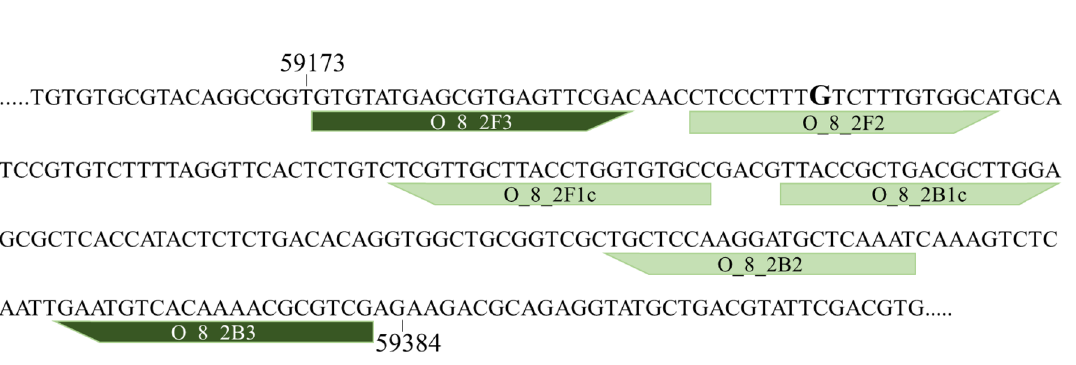
Figure 2. Position and orientation of the primer sequences in the scaffold (accession number CAJHJB010000001) that was used for the development of T. controversa LAMP assay. Binding sites for outer primers are shown in dark green, for inner primers in light green. Separation of the binding part is shown with the (_) in the primer sequences. The numbers show the position of nucleotides in the DNA segment. The nucleotide (G) shown in bold is changed to wobble position (K) in the primer sequence, after resequencing of the target T. laevis (shown in dark red) shared > 99% sequence identity with an average of 91% alignment coverage of the total genome length. In this group, two clades corresponding to common bunt ( T. caries and T. laevis ) and dwarf bunt ( T. controversa ) were discriminated using single linkage cluster analysis. Tilletia caries and T. laevis clustered together in a common clade, with little genetic distance from its neighboring clade comprising the genomes of T. controversa . In comparison, the identity within T. indica genomes was > 97% with an average of 79% alignment coverage. The genomes of T. indica shared on average 94% sequence identity to the single T. walkeri genome. In the second group, T. indica samples were separated from the single representative of T. walkeri. The program rapid identification of PCR primers for unique core sequences (RUCS) 36 was used to identify species-specific sequences in the genome of T. controversa . A total of 11,136 unique DNA segments (N50 = 61 bp) were obtained, of which 22 were longer than 1500 bp. These sequences were used for the design of LAMP primers. A total of 78 primer sets were designed and initially tested for their specificity against a preset comprising eight (three T. caries , three T. controversa , and two T. laevis isolates) selected cultured samples (Supplementary Table S3 shows the list of cultured samples). The primer sets with no false detection and strong amplification as visualized on agarose gels were selected. The second round of testing was performed against the samples of com- mon and dwarf bunt only. The primer sets were excluded when a false positive or false negative reaction occurred. The remaining primer sets were then tested against other Tilletia species and fungal pathogens. The primer set with the lowest false detection rate in this round was finally selected. We tested the selected primer set three times independently against the complete sample collection. Table 1 provides the primer sequences and Fig. 2 shows their location in the target sequence ( T. controversa isolate OR, scaffold accession number CAJHJB010000001). The primer sequences did not show similarity to any relevant species when blasted against GenBank and this 210 bp intergenic region used for the development of the LAMP assay did not produce a BLAST hit when searched at the DNA level against GenBank’s nucleotide collection.